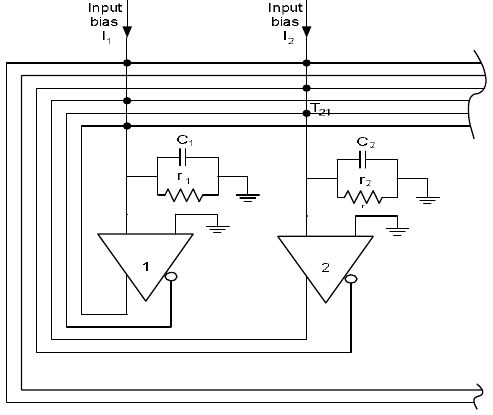
Fig. 1. Hopfield neural network